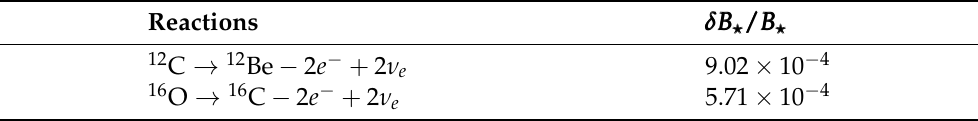
Table 9. Relative decay of the magnetic field required to trigger the chains of electron captures by light nuclei listed in Table 3 in the outer crust of a magnetar for B (cid:63) = 2000, from zero pressure (at the stellar surface) to the pressure at which the last capture occurs.